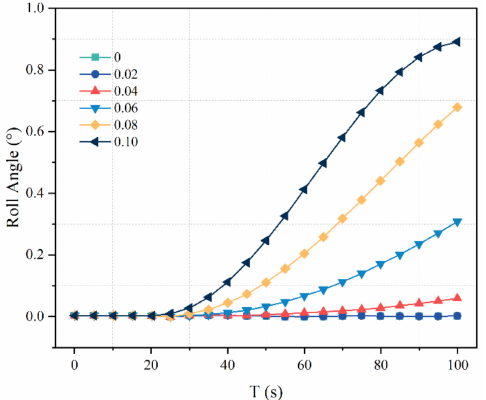
Figure 7. Roll angles under different Munk moment